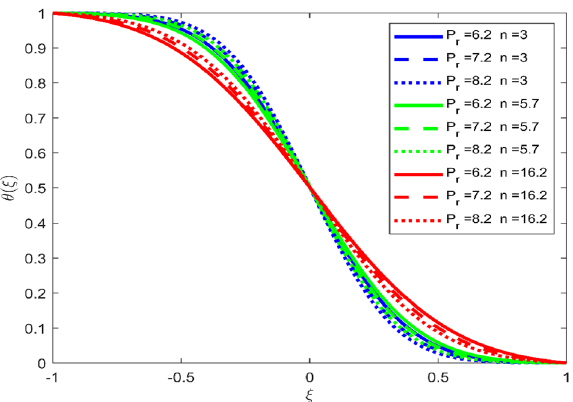
Figure 11. Effect of Ha upon velocity profile H (ξ) , for selected values of β R 0